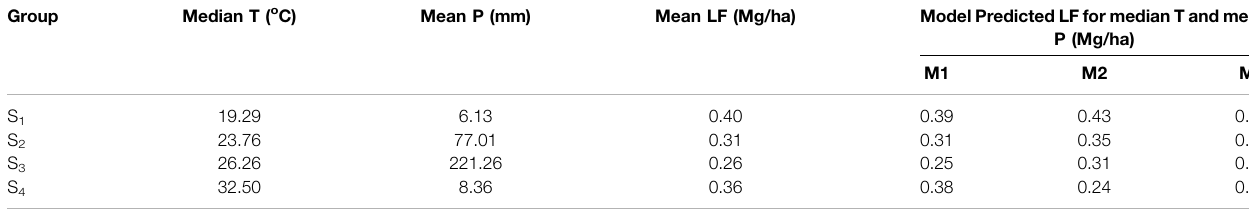
TABLE 6 | Model based predicted LF for different sub - datasets